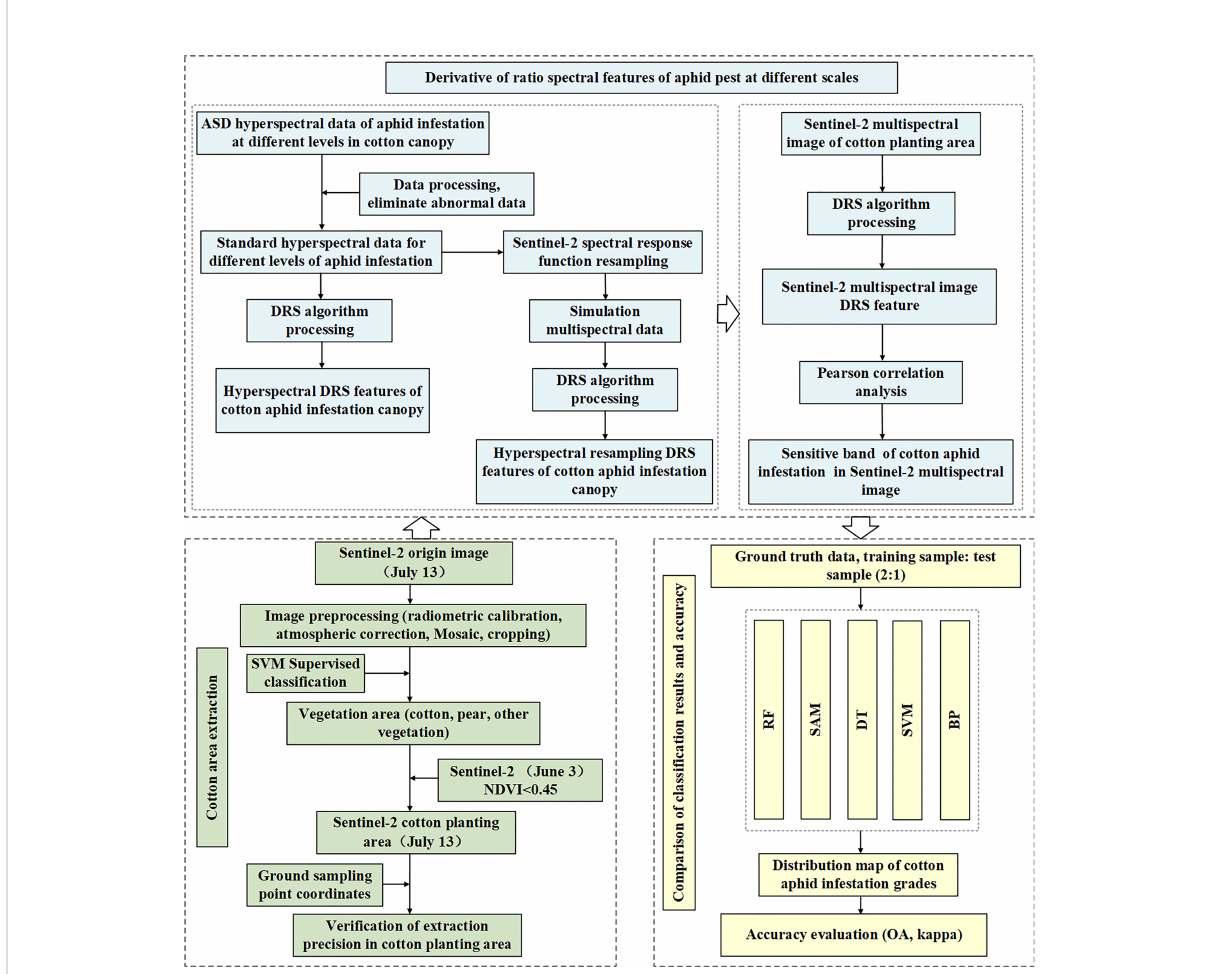
FIGURE 4 Flowchart of cotton aphid infestation classi fi cation at different grades based on Sentinel-2 multispectral